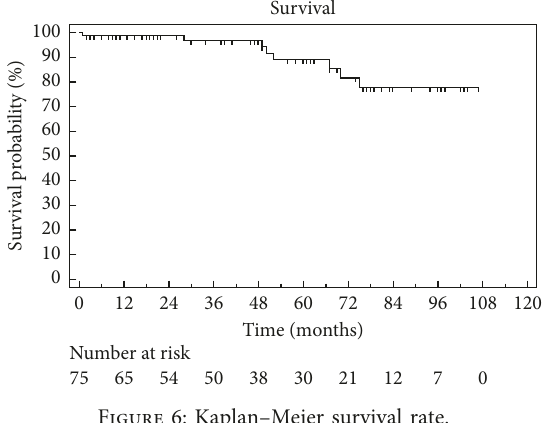
Figure 6: Kaplan–Meier survival